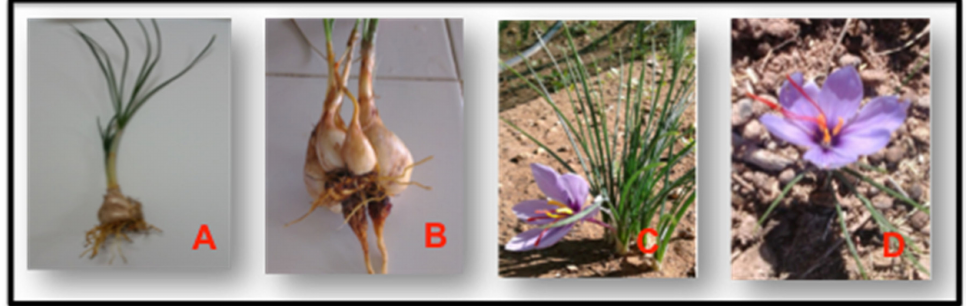
Figure 1. Crocus sativus plant morphology: ( A ) sa ff ron plant; ( B ) types of roots in sa ff ron; ( C ) sa ff ron leaves; ( D ) sa ff ron